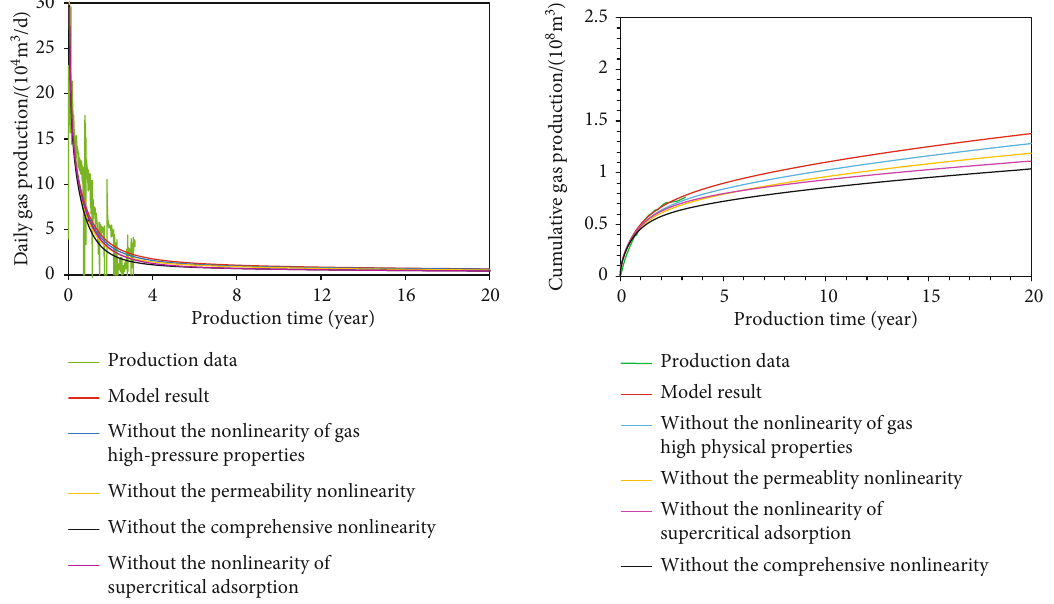
Figure 3: Prediction results of gas production.